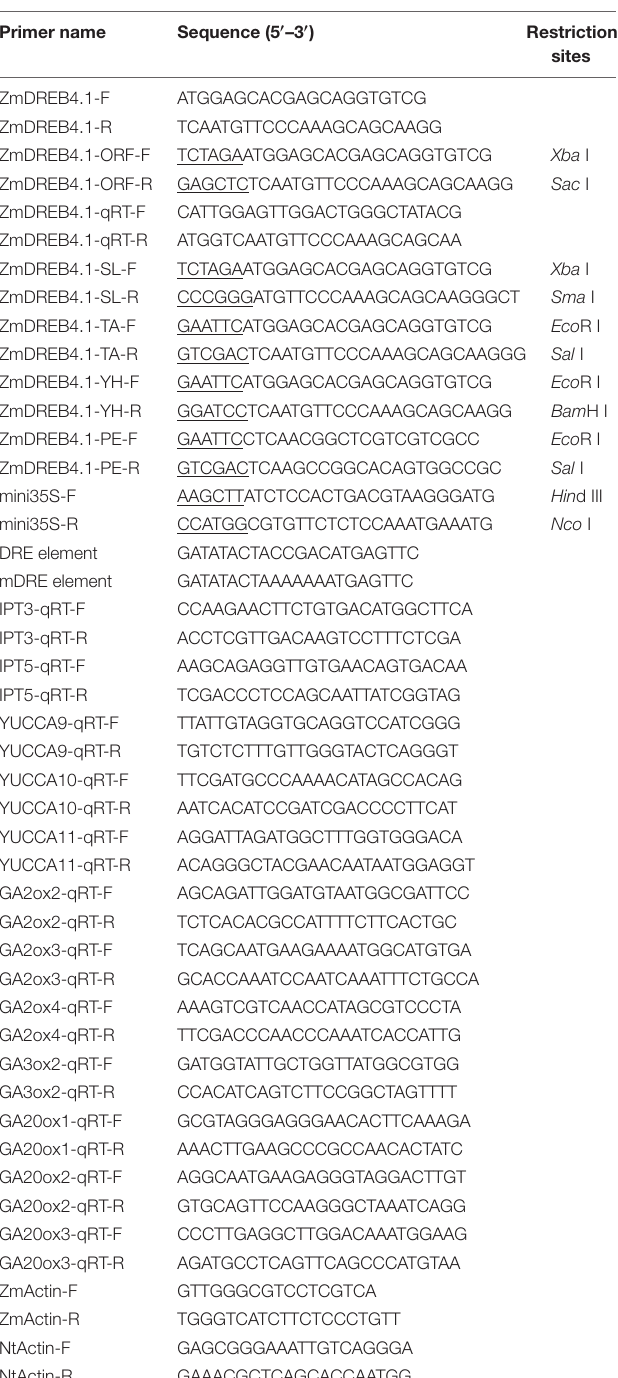
TABLE 1 | Primer sequences used in this